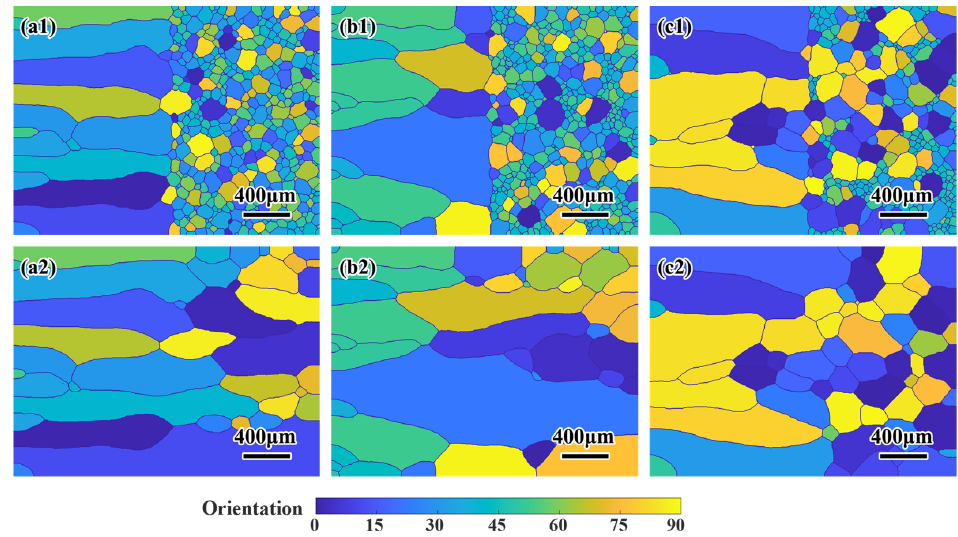
Figure 13. Simulated microstructures with different texture strengths after directional annealing at 3.3 μ m/s. ( a1 , a2 ), ( b1 , b2 ) and ( c1 , c2 ) are the microstructure evolution of orientation variance of 10°, 5° and 2.5°, respectively.